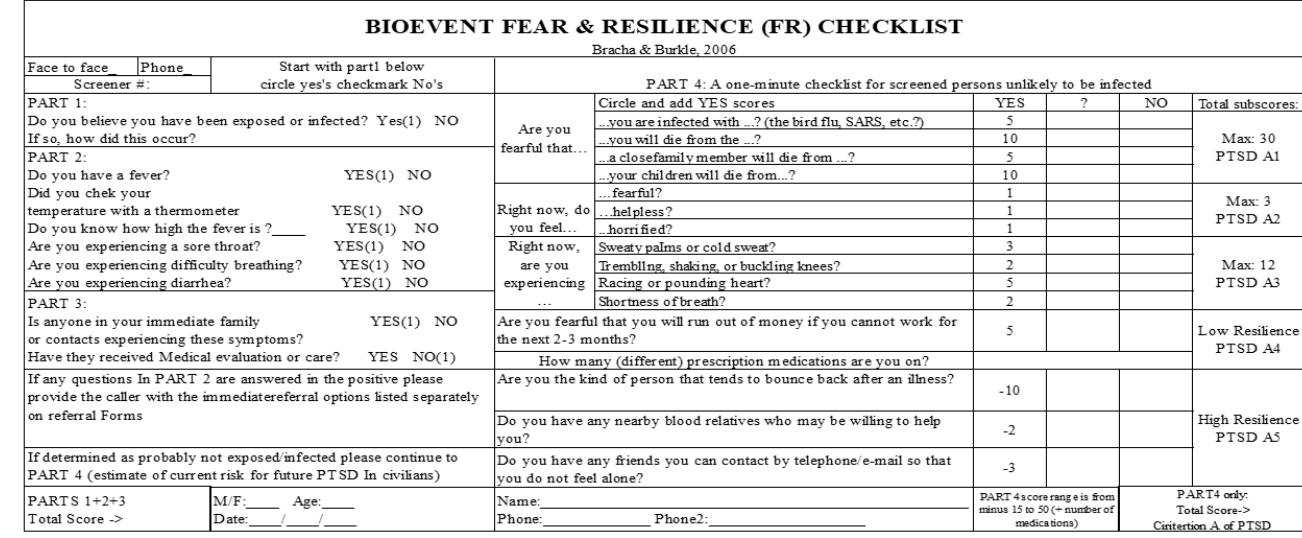
Figure 11. Bioevent fear and resilience checklist [44].